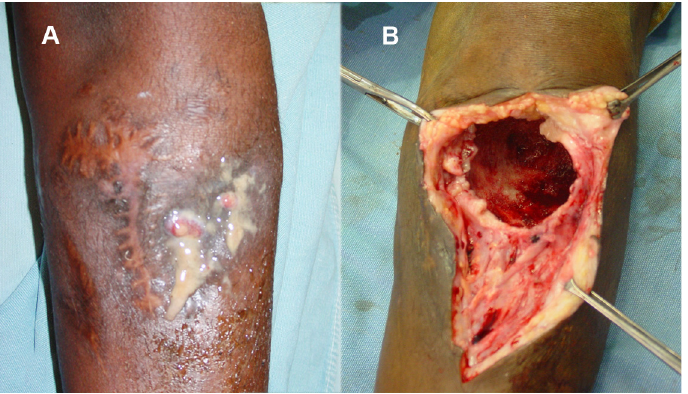
Fig 2. (A) Photograph of a patient with eumycetoma of the upper leg with minimal external appearance. (B) The same patient at surgical exploration, showing massive bone